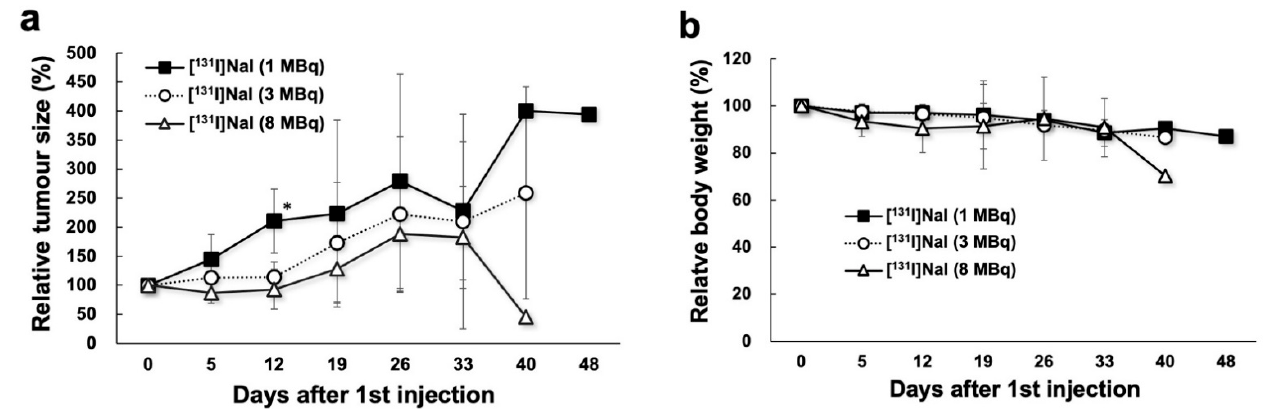
Figure 4. Changes in relative tumour size ( a ) and relative body weight ( b ) in the 1 MBq 131 I, 3 MBq 131 I, and 8 MBq 131 I groups. * p < 0.05 between the 1 MBq and 8 MBq groups.